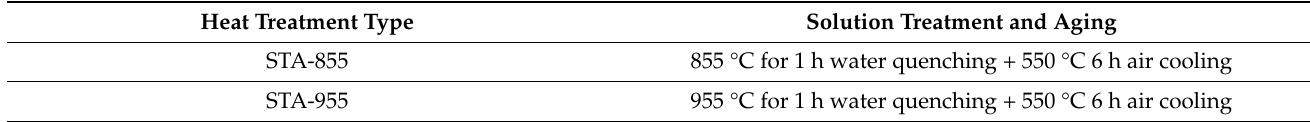
Table 2. The details of two heat treatments performed on Chips-Ti64-3TiB composite material.